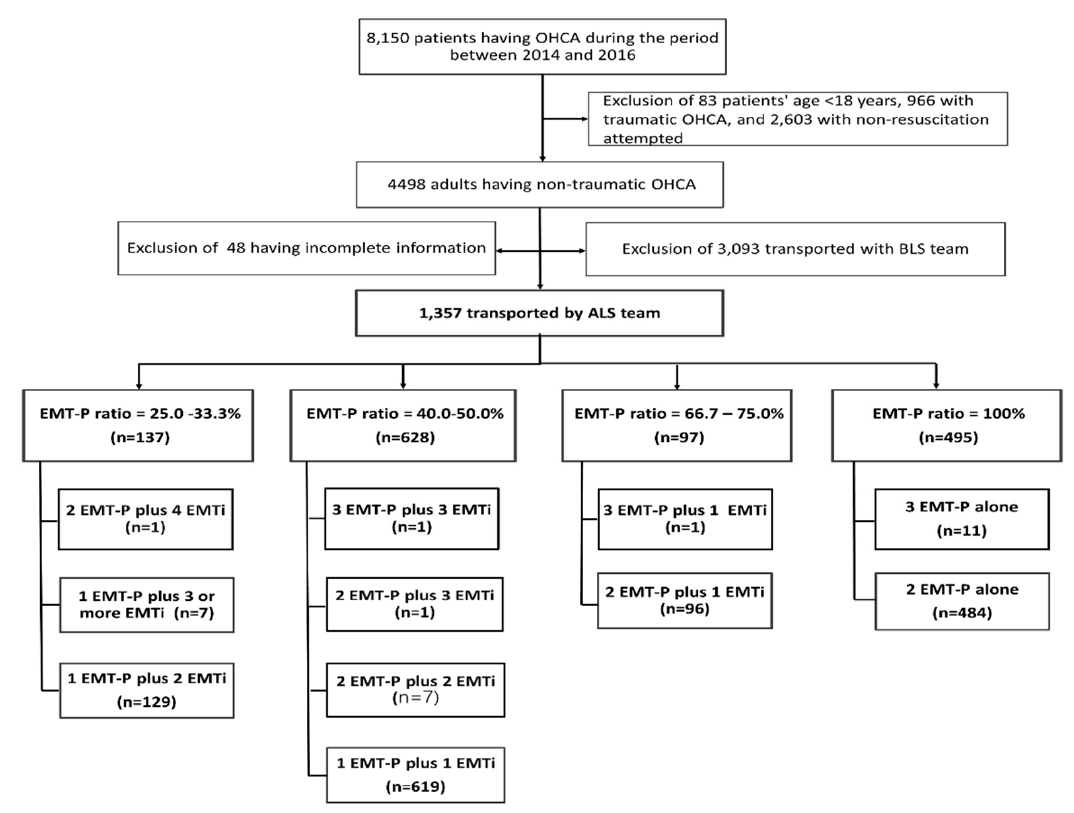
Figure 1. Patient selection flowchart. EMT = emergency medical technician; EMT-I = emergency medical technician-intermediate; EMT-P = emergency medical technician-paramedic; OHCA = out-of-hospital cardiac arrest. EMT-I included EMT-1 and EMT-2.